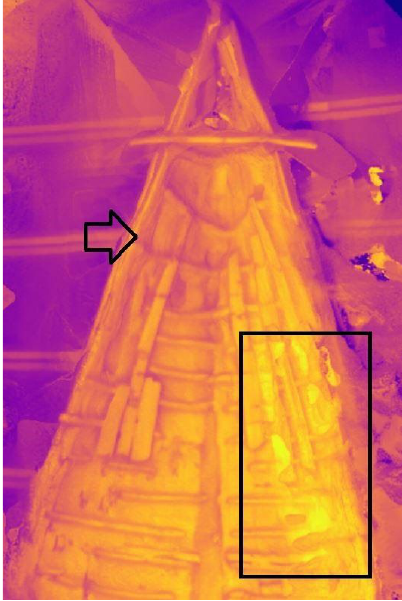
Figure 10. Anomalies of temperature near the bow (in the square the yellow spots are the hottest areas; the arrow indicates the colder areas) The datasets were aligned and fine registered in CloudCompare with the model obtained by the Nikon as reference; the RMS is between 0.022 and 0.025 m. The distance among the point-clouds calculate by CloudCompare shows an average distance of 0.003 m. All the three datasets were merged and sampled by removing the duplicate points at a distance greater than 0.001 m. The final model is 31 million points larger than the Nikon one.